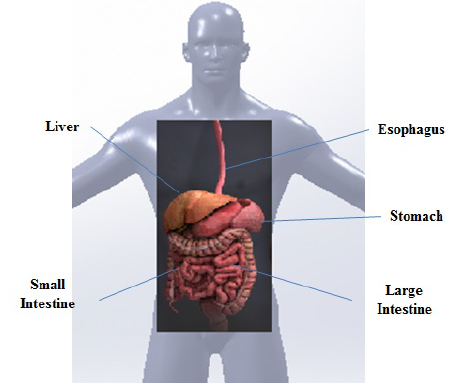
Figure 1. GI tract of the human body.